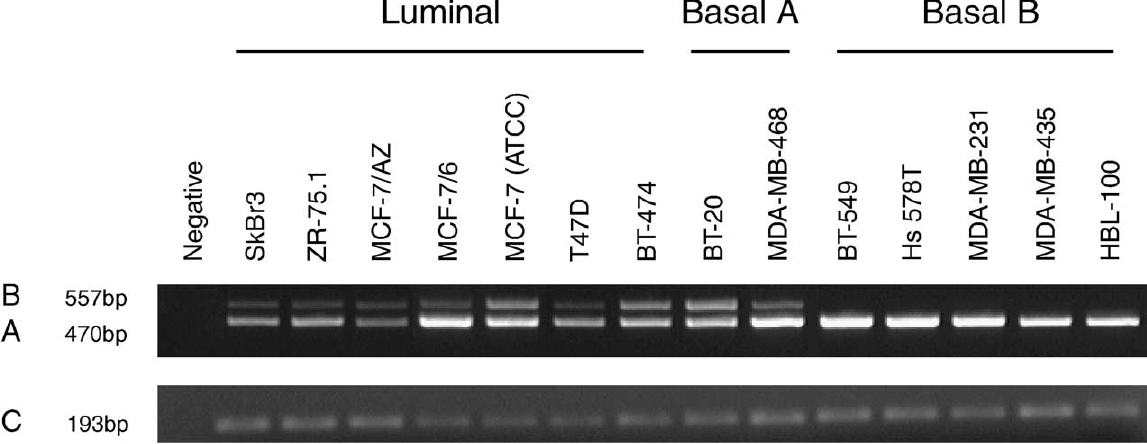
Fig. 4. mRNA expression of p120ctn isoforms generated by the alternative use of exons 20 (B), 18 (A) and 11 (C), in breast cancer cell lines. Numeric isoform codes and their sizes are indicated on the